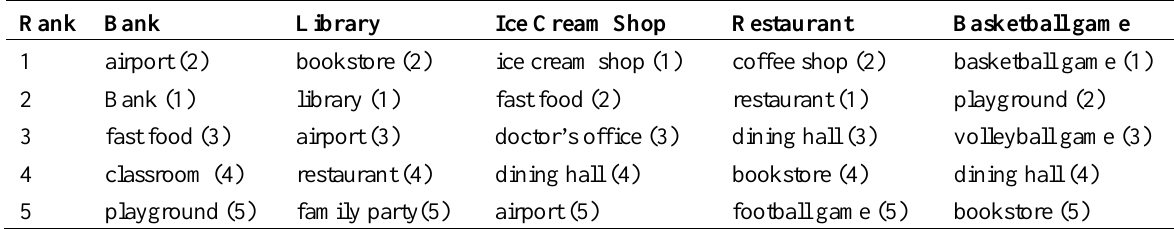
Table 3. The mean rankings of each comparison setting (names) relative to the target setting